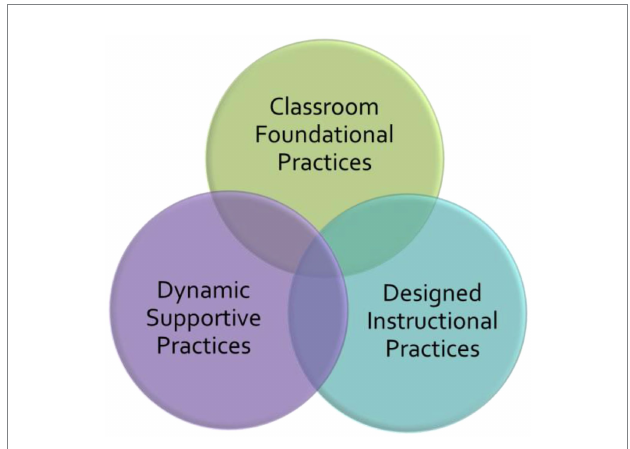
FIGURE 1 A culturally responsive self-regulated learning framework. Source: Adapted from Anyichie